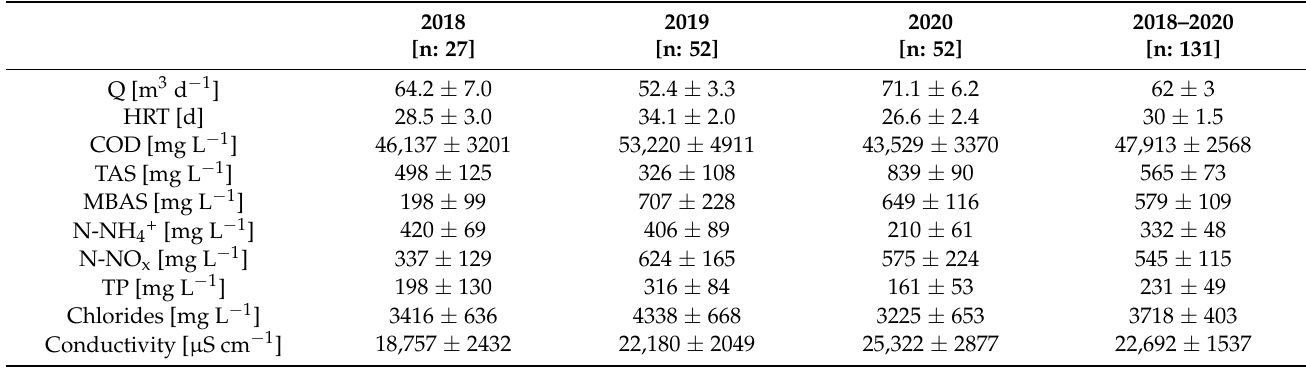
Table 1. Summary of flowrate, HRT, chemical and physicochemical parameters of high-strength WW fed to the ThMBR during the monitoring period. HRT: hydraulic retention time; TAS: non-ionic surfactants; MBAS: anionic surfactants; TP: total phosphorus. n: number of data